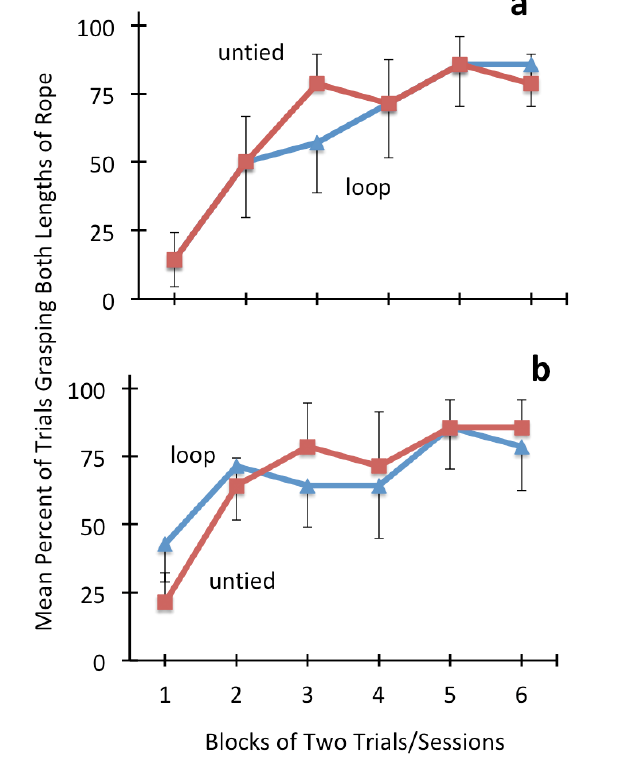
The Mean Percent of Trials (± SEM) in which the Apes’ (a) Initial and (b) Final Actions on the Ropes Involved Grasping Both Lengths of Rope, Depicted by